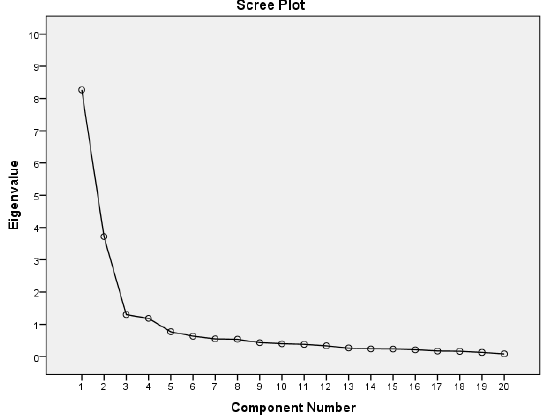
Figure 1. Scree plot of SHALOM–Ideals.